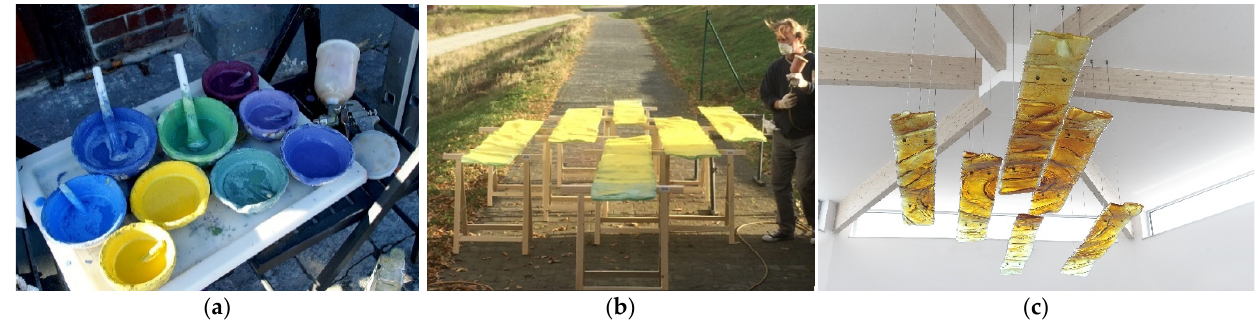
Figure 4. ( a ) Colorful metal oxides at the Archiglass studio, 2018; ( b ) Tomasz Urbanowicz pigmenting The Spirit of Health glass composition using airbrushing at the Archiglass studio, 2018; ( c ) The Spirit of Health suspended glass art composition by Tomasz Urbanowicz and Konrad Urbanowicz at the Integrative Medical Center in Żerniki Wrocławskie, Poland, 2018 (Konrad Urbanowicz).